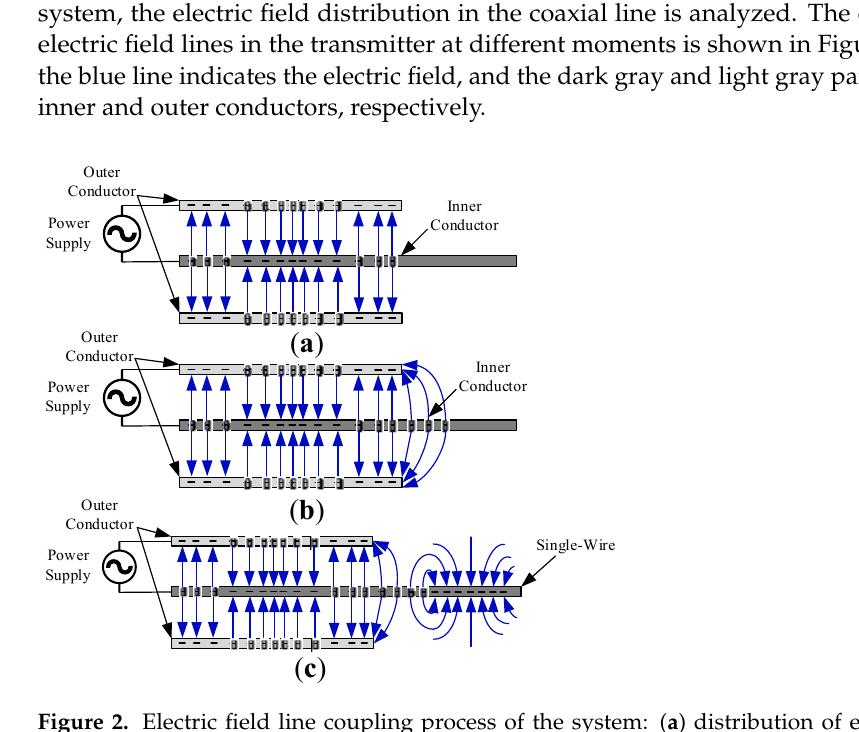
Figure 2. Electric field line coupling process of the system: ( a ) distribution of electric field line on coaxial line; ( b ) the electric field lines begin to bend; ( c ) electric field lines are coupled on the single- wire.